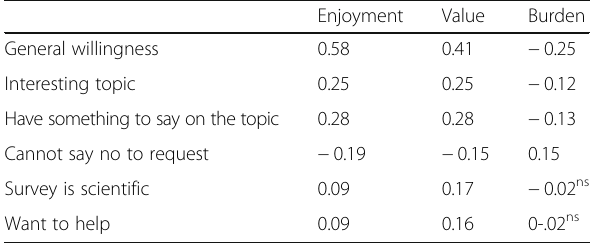
Table 3 Correlations between survey attitude scales and reasons for previous survey participation questions: PPSM panel